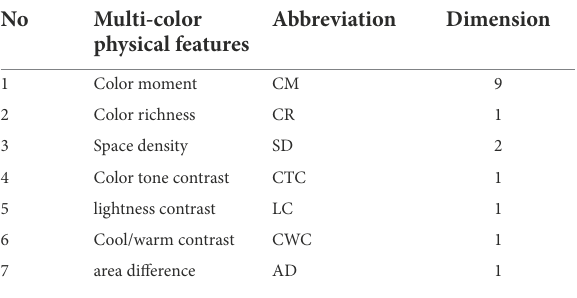
There are seven categories of multi-color physical features. From left to right, the second column represents the description of each feature, the third column represents the abbreviation composed of the capital letters from the corresponding feature description, and the fourth column represents the dimensions of each